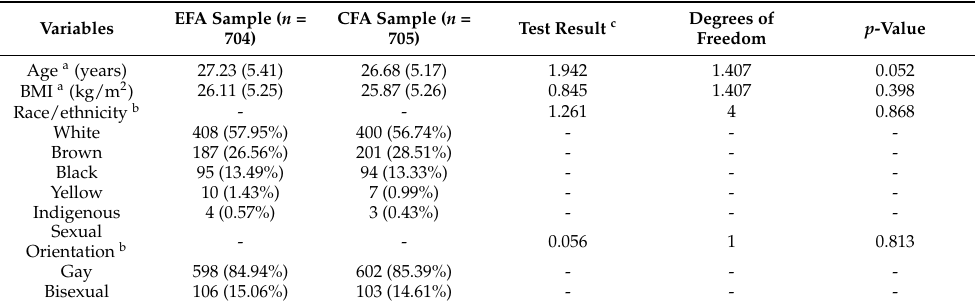
Table 1. Descriptive statistics and test of differences between the exploratory factor analysis (EFA) and confirmatory factor analysis (CFA) samples on